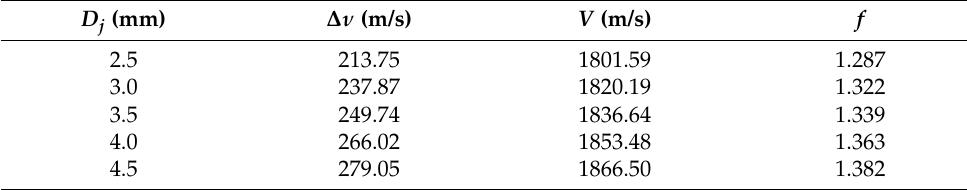
Figure 13. Trajectory of detonation front along lower wall based on five jet diameters. Table 6. Detonation wave parameters for different jet